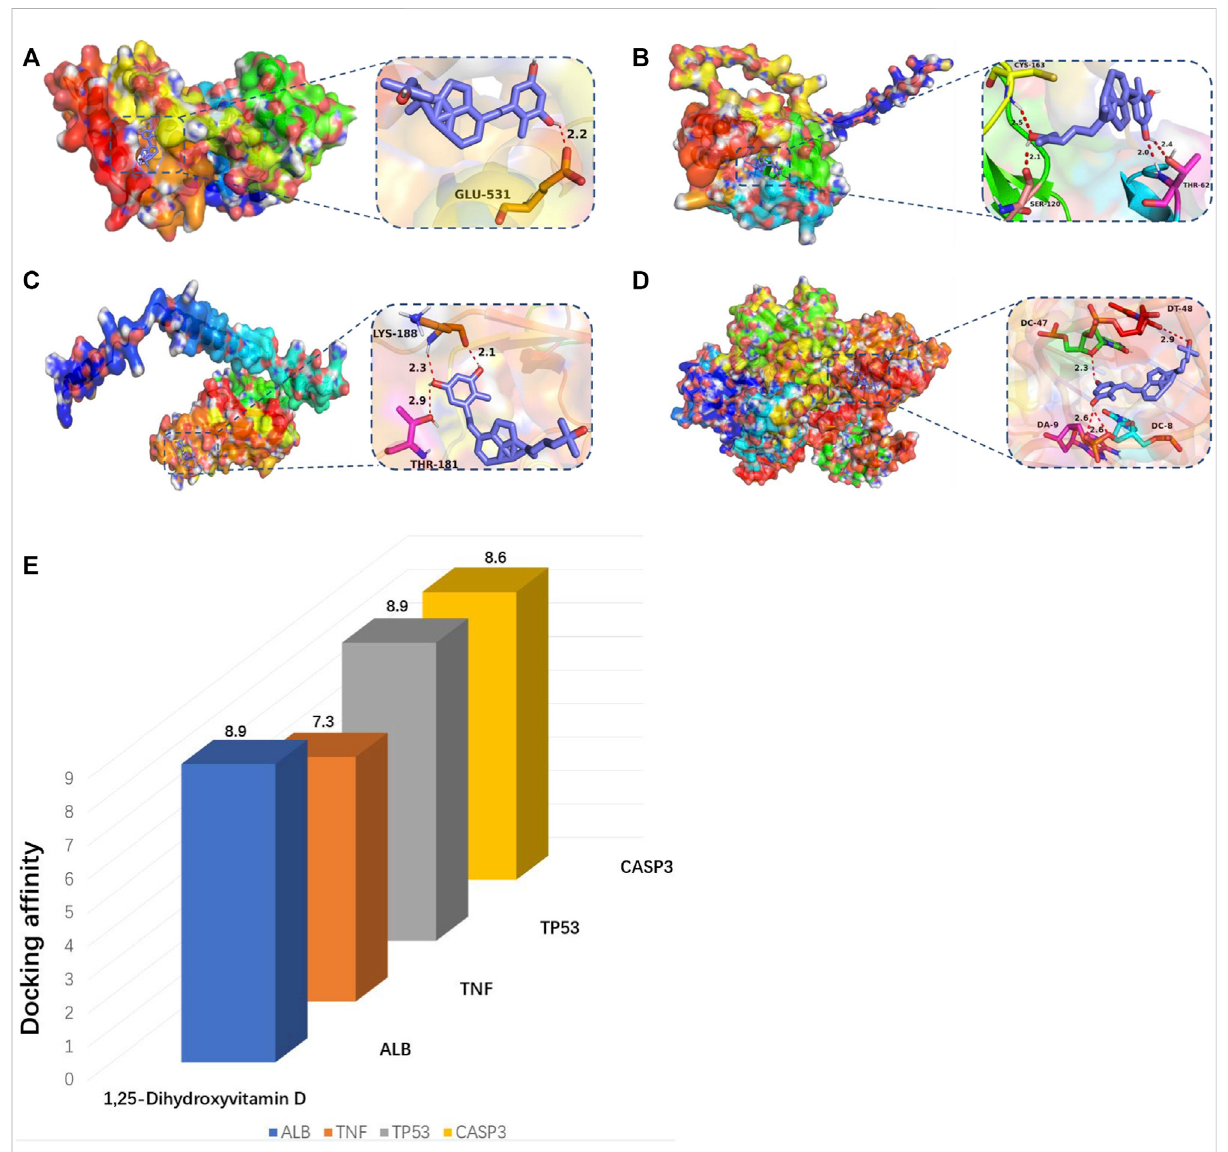
FIGURE 8 (A – E) Molecular docking map of key genes: (A) ALB and 1,25-Dihydroxyvitamin D (-8.9 kcal/mol); (B) CASP3 and 1,25-Dihydroxyvitamin D ( − 8.6 kcal/mol); (C) TNF and 1,25-Dihydroxyvitamin D ( − 7.3 kcal/mol); (D) TP53 and 1,25-Dihydroxyvitamin D ( − 8.9 kcal/mol). (E) Bar diagram of molecular docking binding